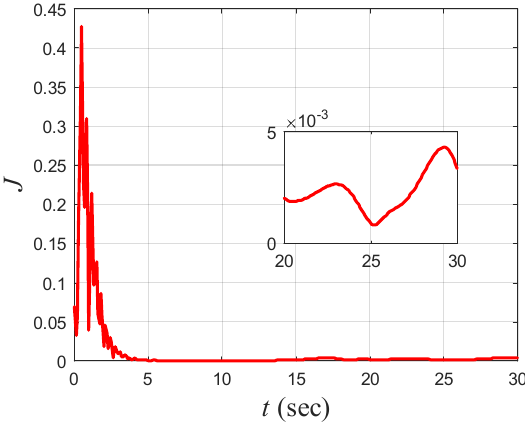
Figure 10. The cost function. Figure 10. The cost